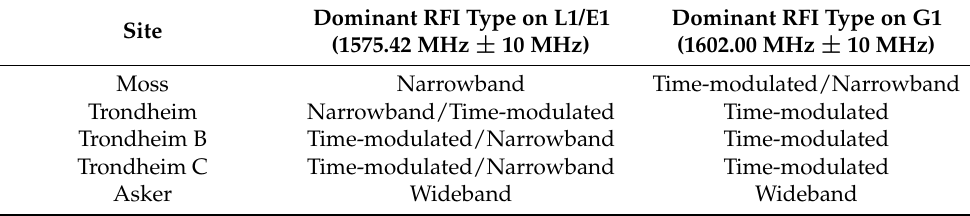
Table 7. Summary of the dominant RFI type per site for the L1/E1 and G1 frequency bands.